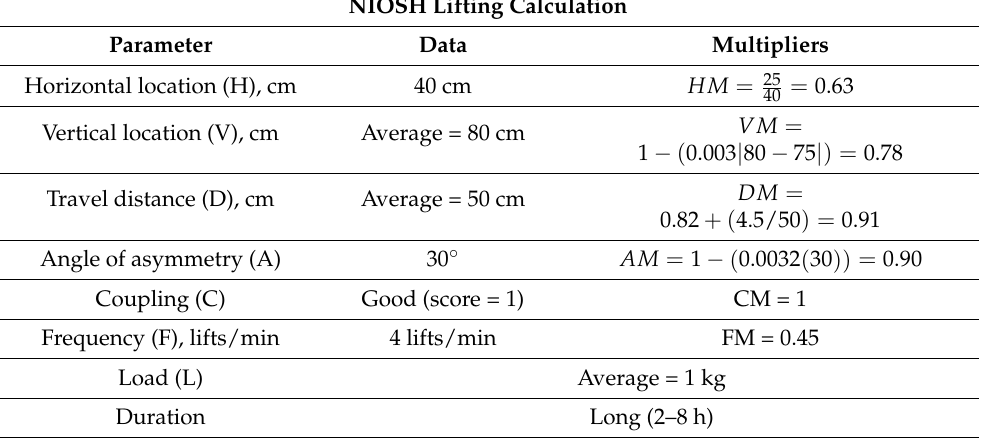
Table A4. NIOSH data after improvement. NIOSH Lifting Calculation Parameter Data